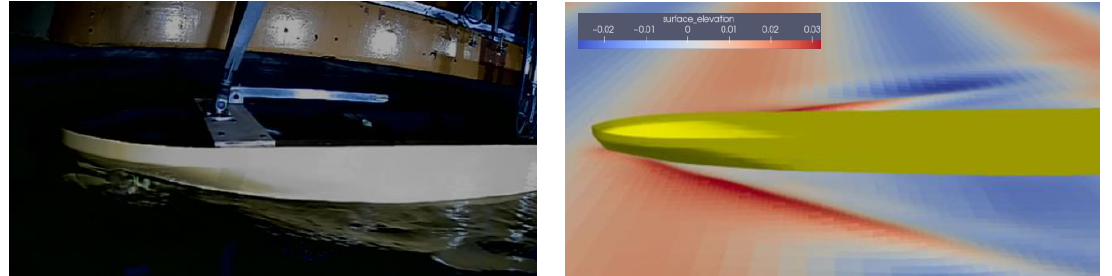
Table 5. Percentage